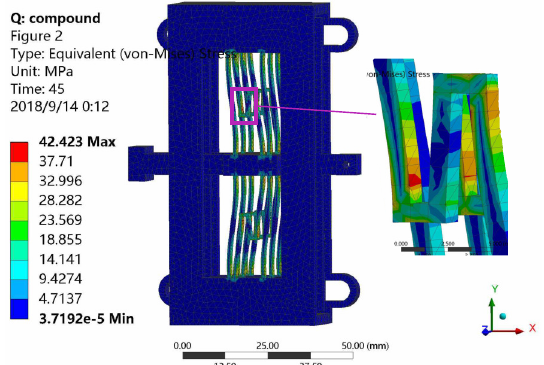
Figure 6. Simulation result of stress distribution for the CCFM with the displacement ∆ x applied in x